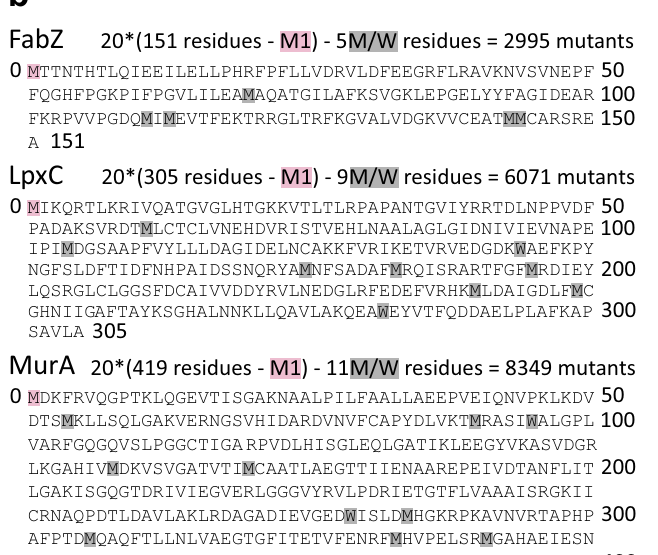
mutations that prevent re-cutting by eliminating the PAM site. b In the FabZ, LpxC andMurAsaturationeditinglibraries,everyaminoacidwasreplacedbyall19other amino acids, except for the start codon which was not mutated. Additionally, as a control, everycodon was mutated to a synonymous codon, exceptfor methionine (M) and tryptophan (W) residues for which no synonymous codons exist. This results in a total of 20 (or 19 for M and W residues) mutations per amino acids, leading to 17,415 variants across all three